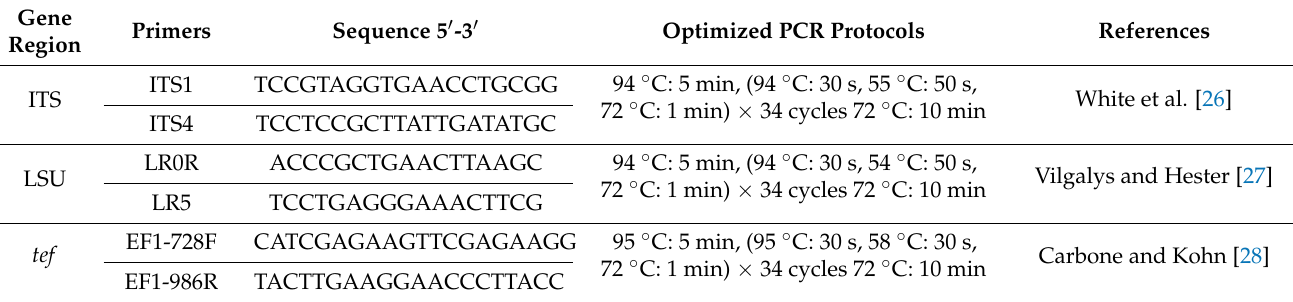
Table 2. Details of gene regions, respective primer pairs, primer sequences, and PCR conditions used in the study. Gene Region